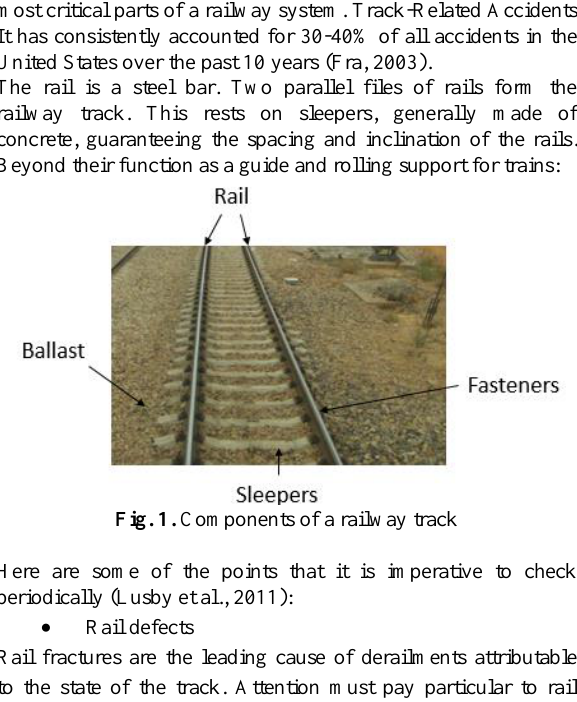
Fig. 2. A figure Sample of track fault cracked-rail (a) damage from collision, (b) Broken rail (c) Flood, (d,e) material theft(f